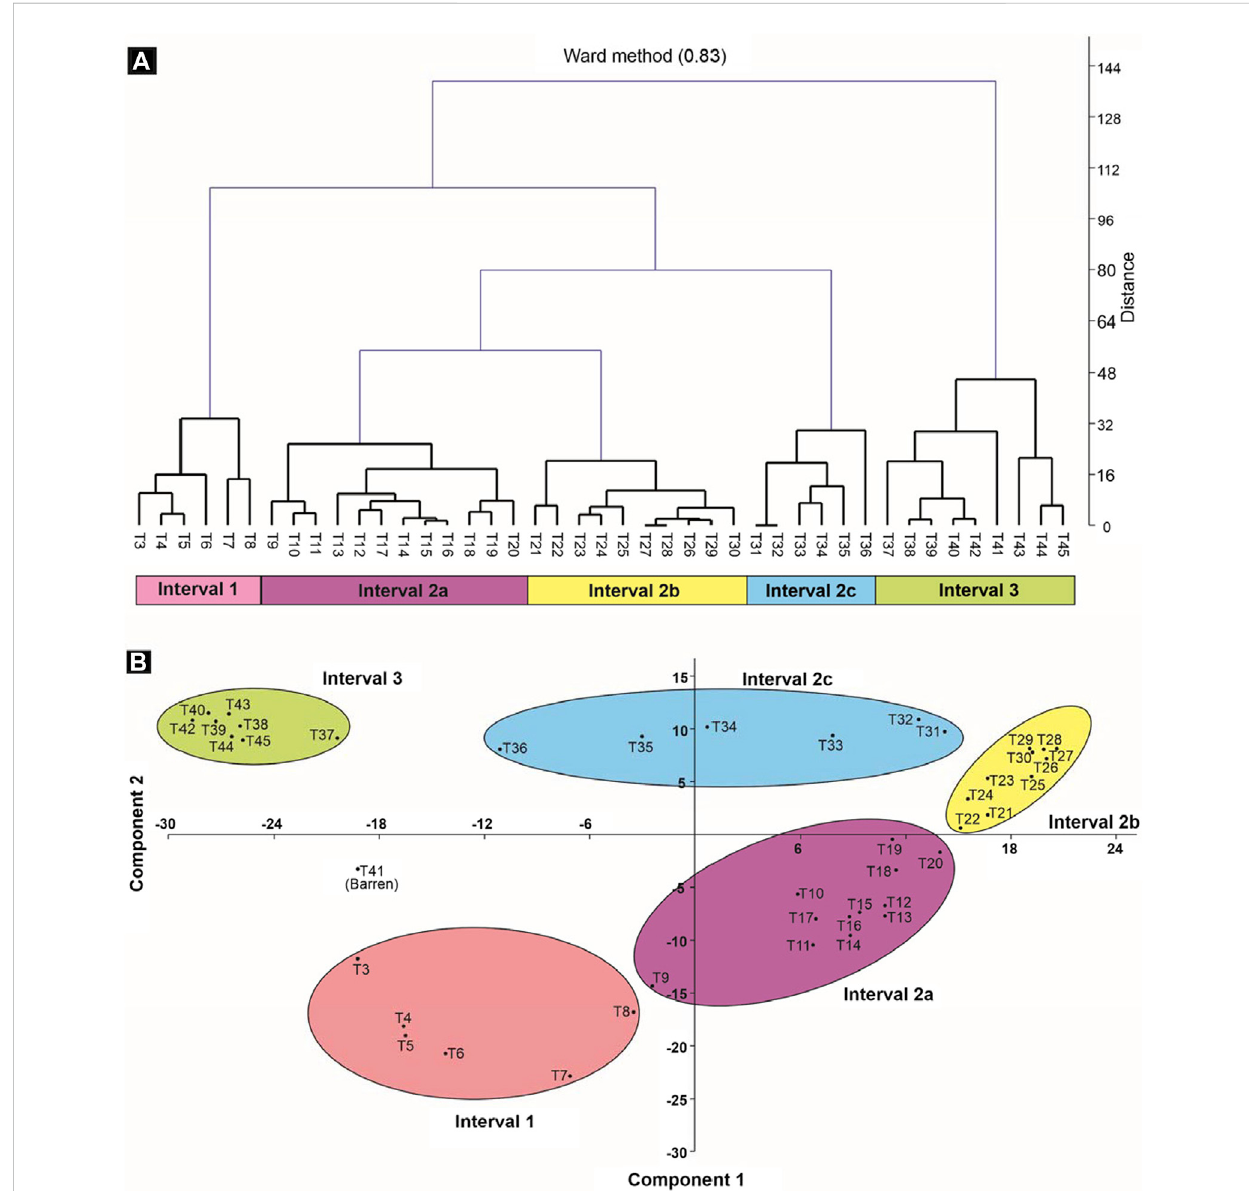
FIGURE 6 Quantitative analyses. Two analyses were used to de fi ne intervals in the present study (Intervals 1 – 3), hierarchical clustering (A) and principal component analysis (B)